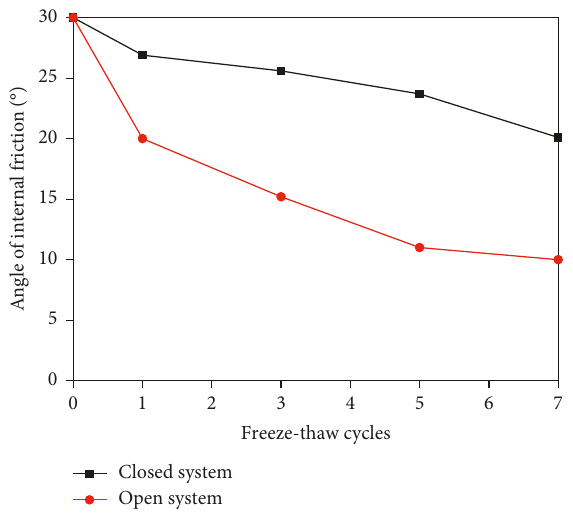
Figure 14: Variation of internal friction angle with the number of freeze-thaw cycles.